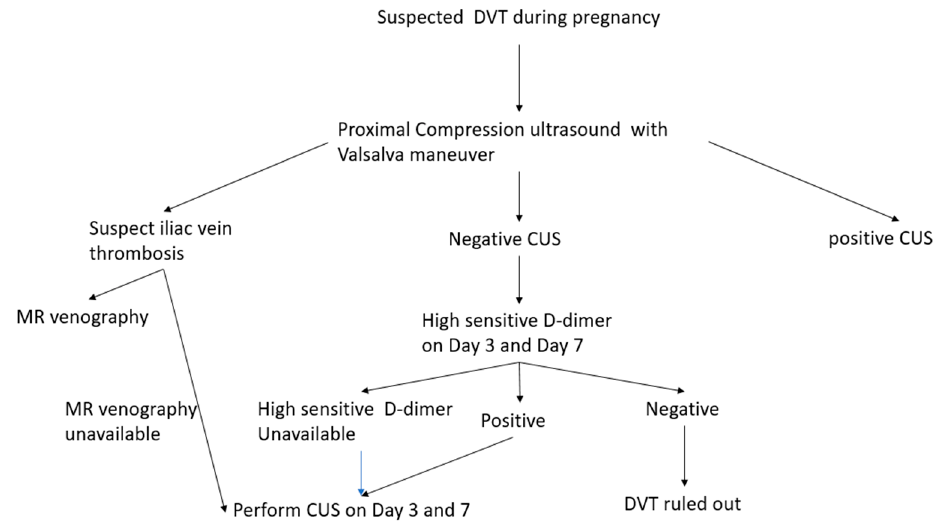
Figure 4. Diagnostic algorithm for evaluation of suspected DVT during pregnancy.